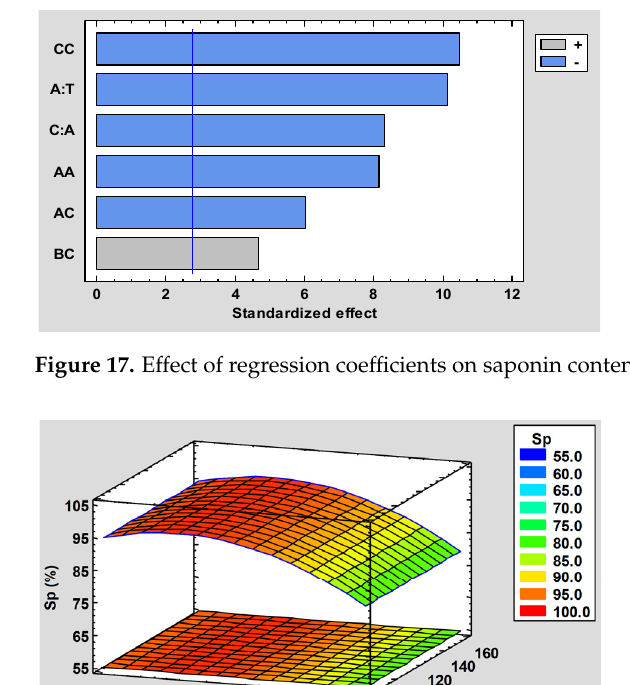
Figure 19. Effect of T and A on saponin content Sp.